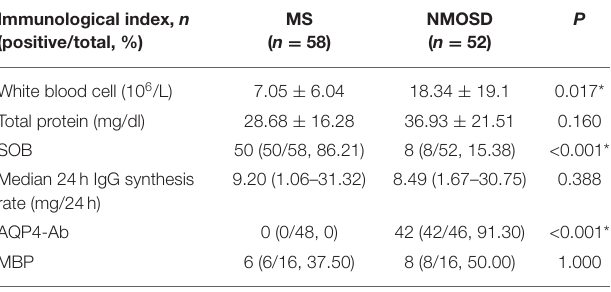
TABLE 4 | Immunological